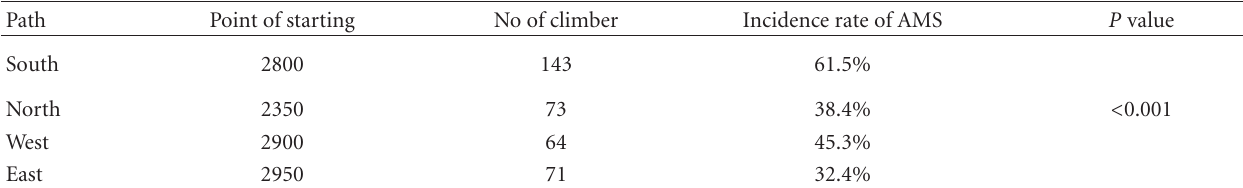
Table 2: The incidence rate of AMS in trekkers in each path of Mount Damavand.